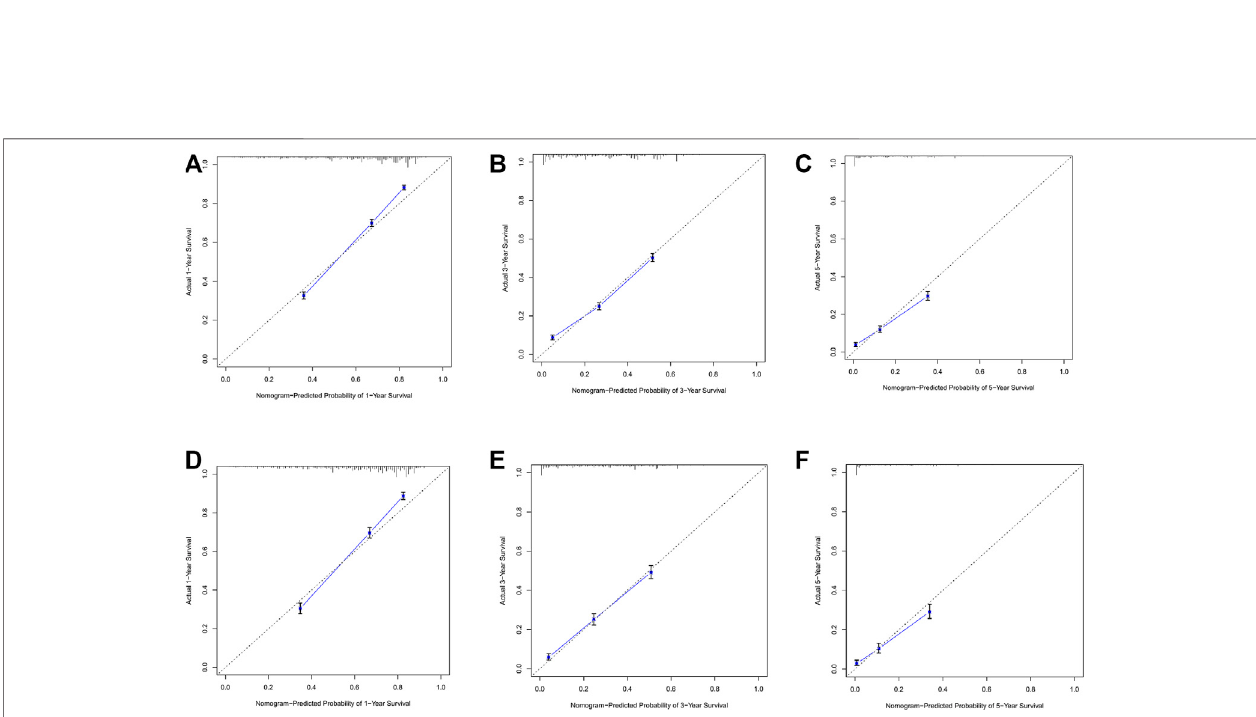
FIGURE 4| (A – C) Nomogram calibration plots to predict 1-,3-, and 5-year overall; survival(OS) in the training cohort; (D – F) Nomogram calibration plots to predict 1-,3-, and 5-year overall survival (OS) in the validation cohort.